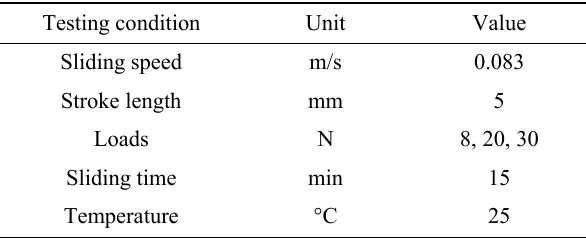
Table 2 Tribological testing